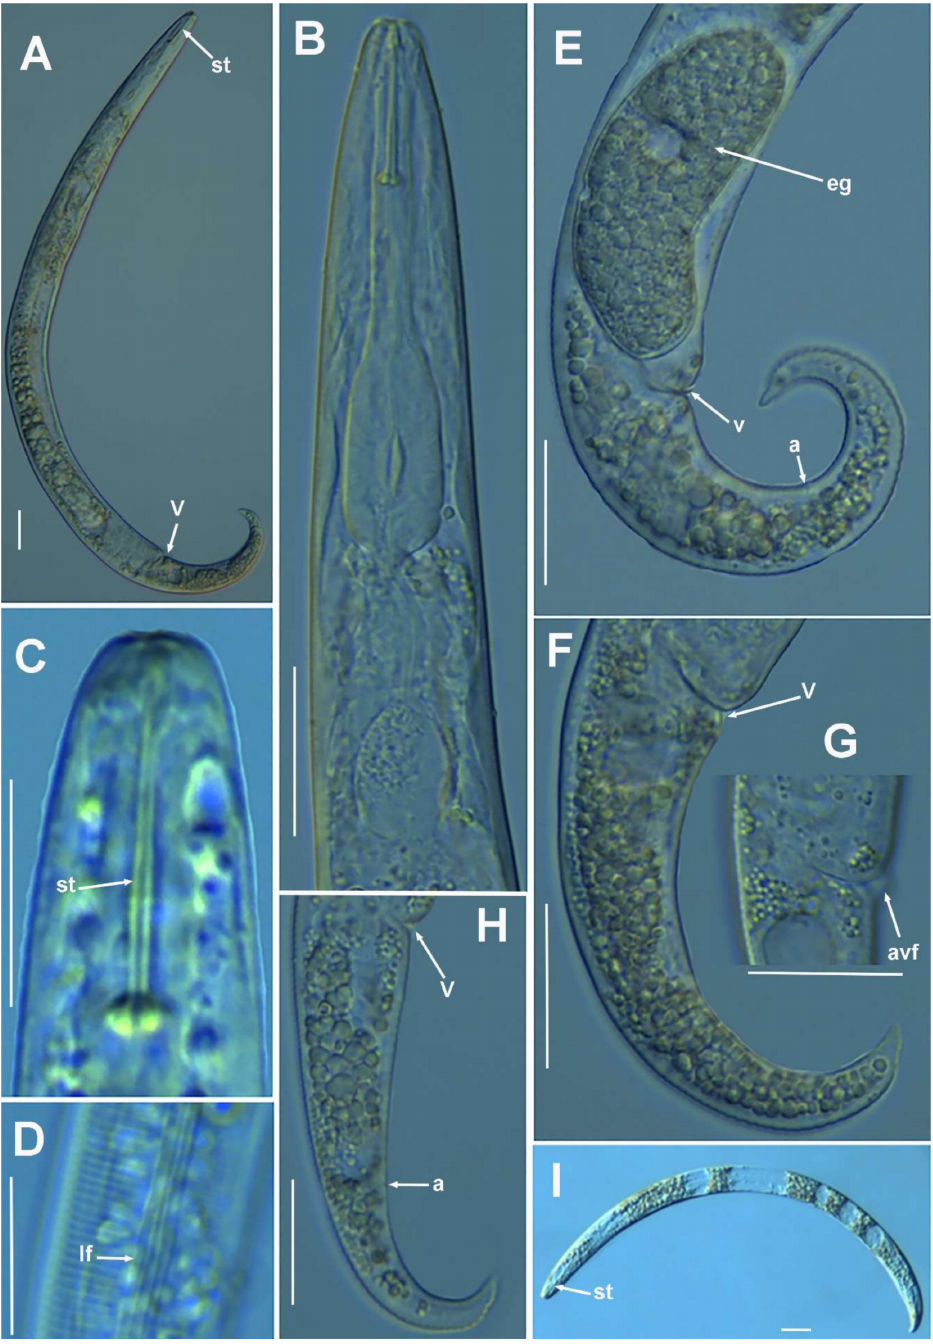
Figure 5. Light photomicrographs of Paratylenchus amundseni Bernard, 1982. ( A ) Entire female with vulva arrowed; ( B ) female pharyngeal region; ( C ) female lip region; ( D ) detail of lateral field; ( E – H ) female posterior region with vulva, anus, and advulval flap (arrowed); ( I ) entire fourth-stage juvenile with stylet (arrowed). Scale bars ( A – I = 20 µ m). (Abbreviations: a = anus; avf = advulval flap; eg = egg; lf = lateral field; st = stylet; V =